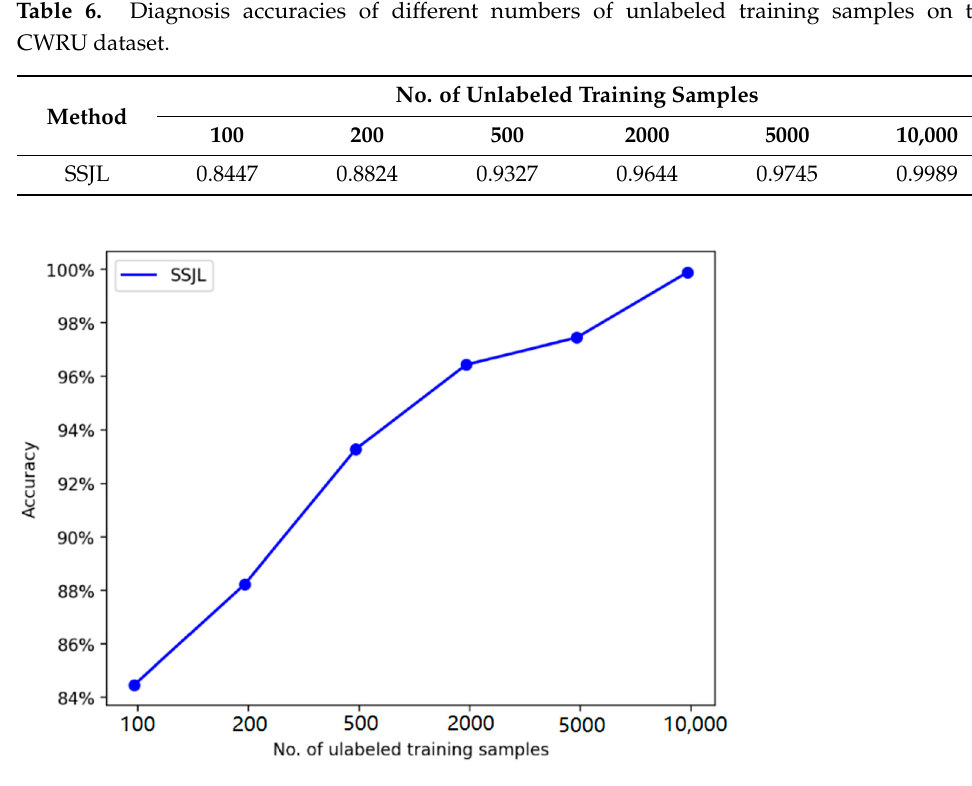
Figure 9. Diagnosis accuracies using a different number of unlabeled training samples on the CWRU dataset. CWRU